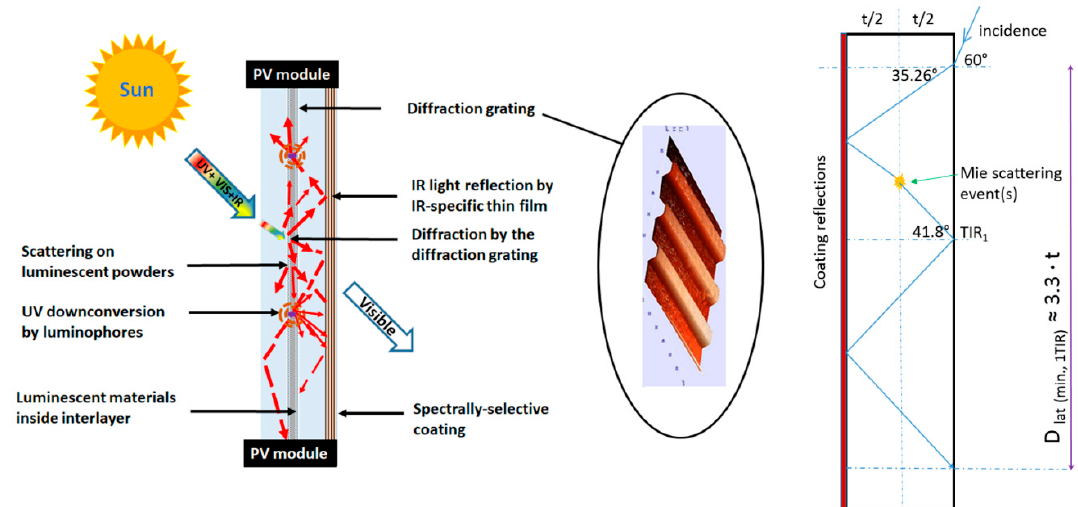
Figure 4. Semitransparent hybrid concentrator-type photovoltaic (PV) windows utilising physical mechanisms other than luminescence for inducing waveguiding-type propagation towards edge-mounted solar cells. The drawing on the right-hand side of the figure illustrates the minimum lateral displacement of photons incident at a 60° angle and travelling within a coating-assisted concentrator structure, after only a single total internal reflection (TIR) event, enabled by internal ray deflection. The minimum internal lateral displacement of partially-trapped photons incident at this angle is shown to be more than triple the system thickness dimension.